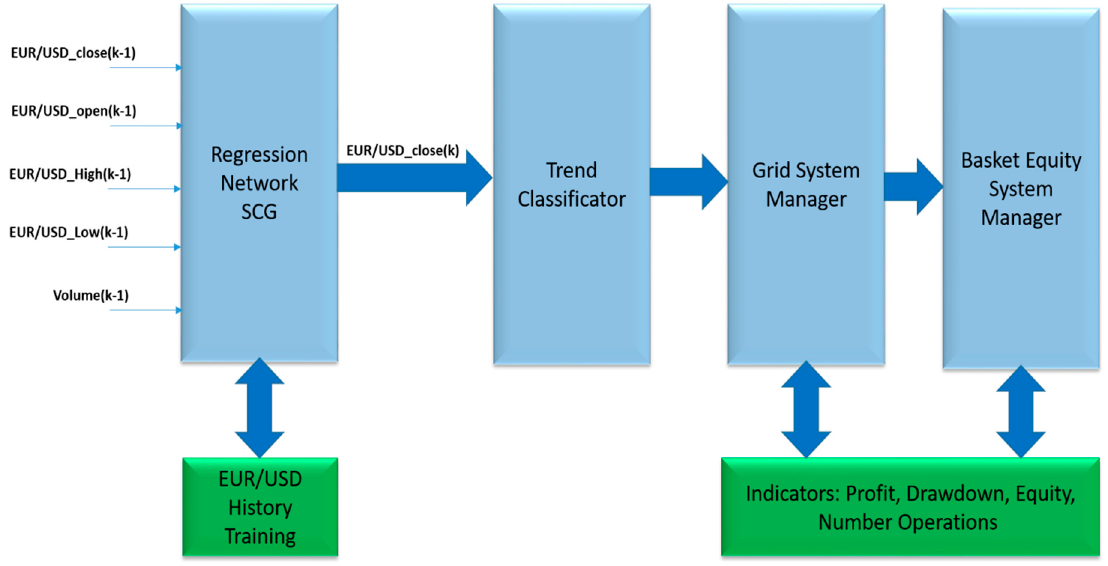
Figure 1. The proposed grid trading system robot (GTSbot) pipeline: Overall scheme .